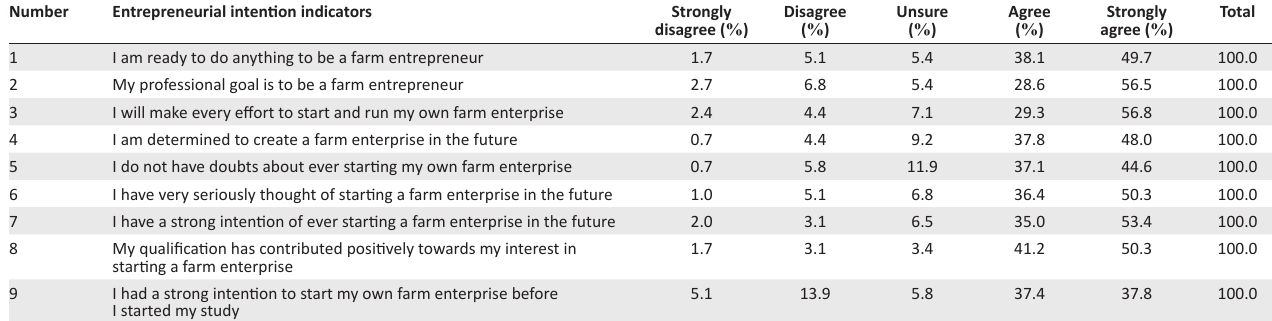
TABLE 7: Farm entrepreneurial intention of the respondents ( N = 294). Number